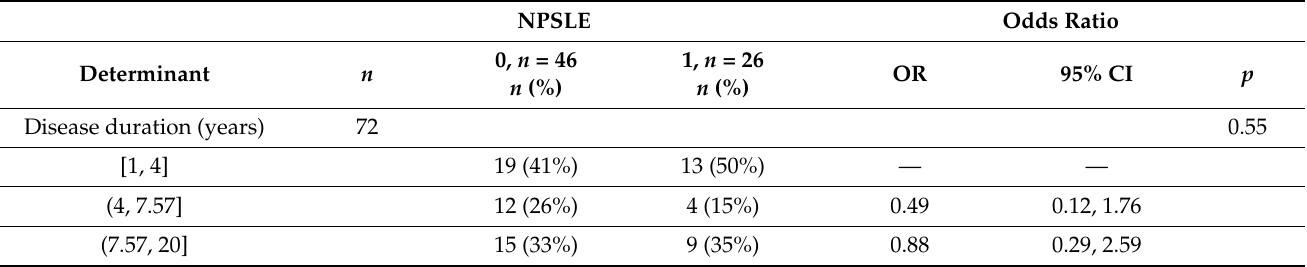
Table 5. Determinants of disease activity in a group of NPSLE